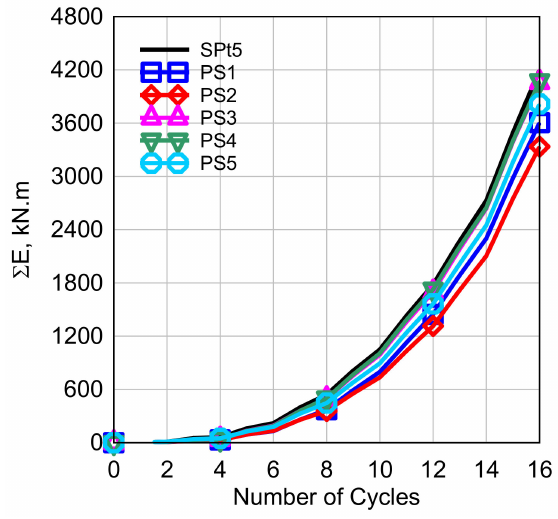
Figure 7. Accumulated energy dissipation